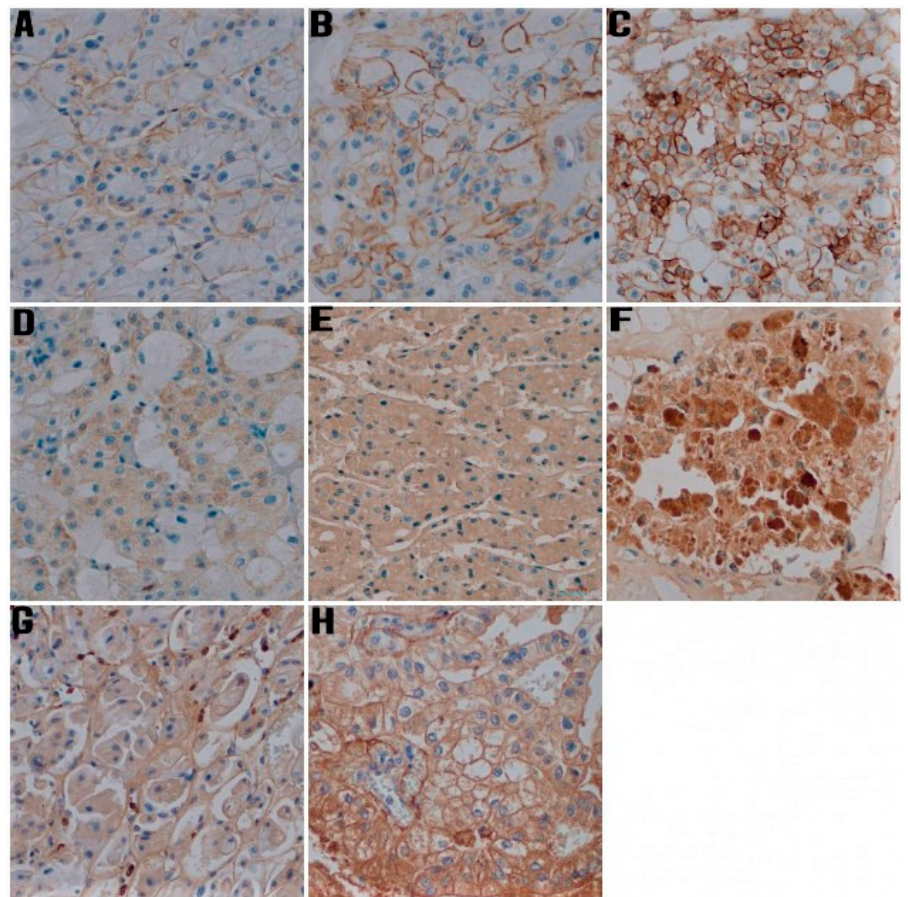
Figure 2. Representative photomicrographs of immunohistochemical staining for CD44, MMP-2, and MMP-9 in chromophobe renal cell carcinoma (IHC, ×400). ( A ) Weak staining intensity for CD44, ( B ) intermediate staining intensity for CD44, ( C ) strong intensity for CD44, ( D ) Weak staining intensity for MMP-2, ( E ) intermediate staining intensity for MMP-2, ( F ) strong intensity for MMP-2, ( G ) Weak staining intensity for MMP-9, ( H ) intermediate staining intensity for MMP-9.